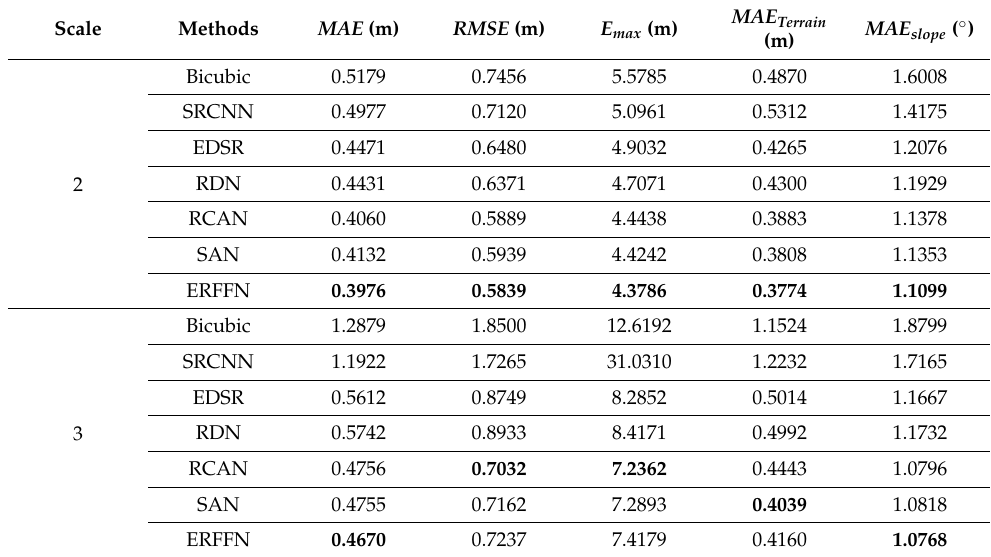
Table 1. Performance evaluation of SR models at various reconstruction scales trained on the Maryland DEM datasets.